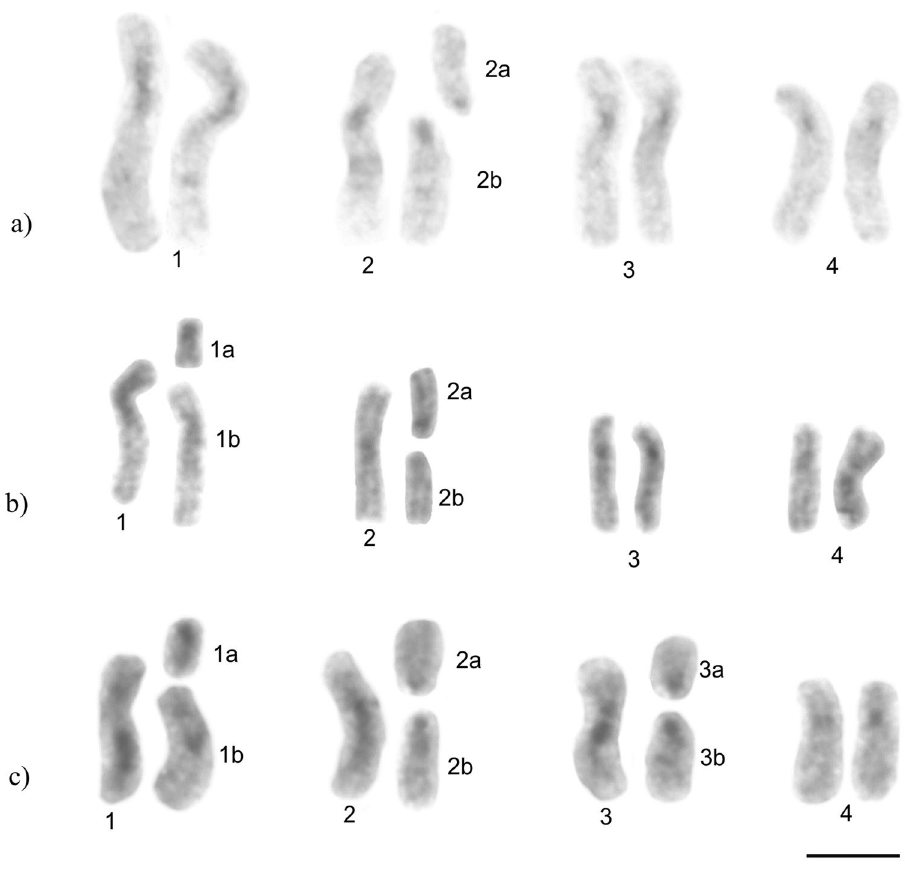
Figure 4. Mycocepurus smithii karyotypes from the asexual population marked with the C-banding technique for heterochromatin detection: ( a ) 2n = 9, ( b ) 2n = 10 and ( c ) 2n = 11. Scale bar represents 5